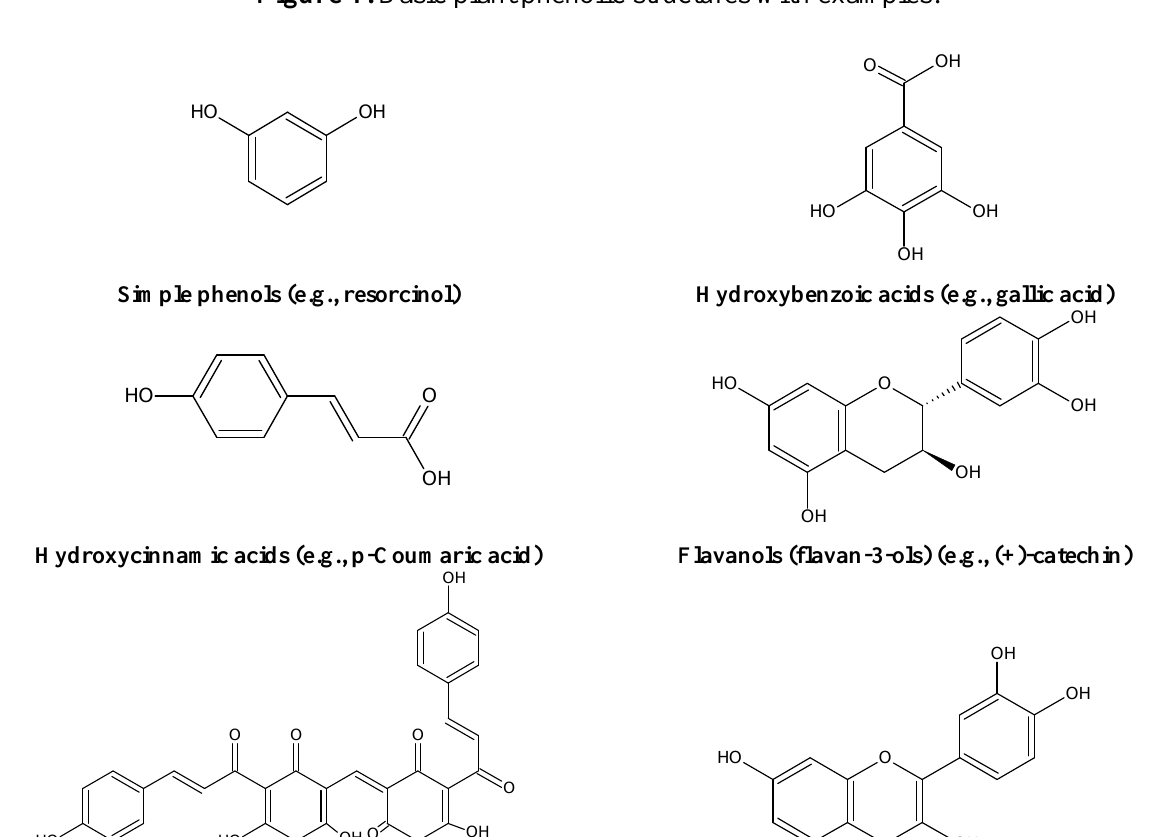
Figure 1. Basic plant phenolic structures with